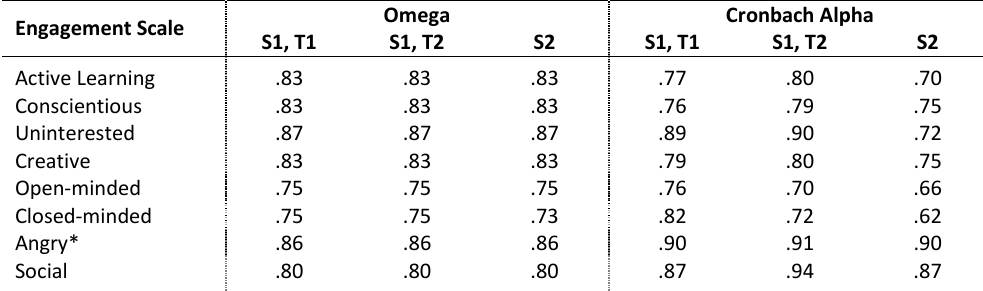
Table 1. Preliminary Analyses: Single Factor Reliabilities Engagement